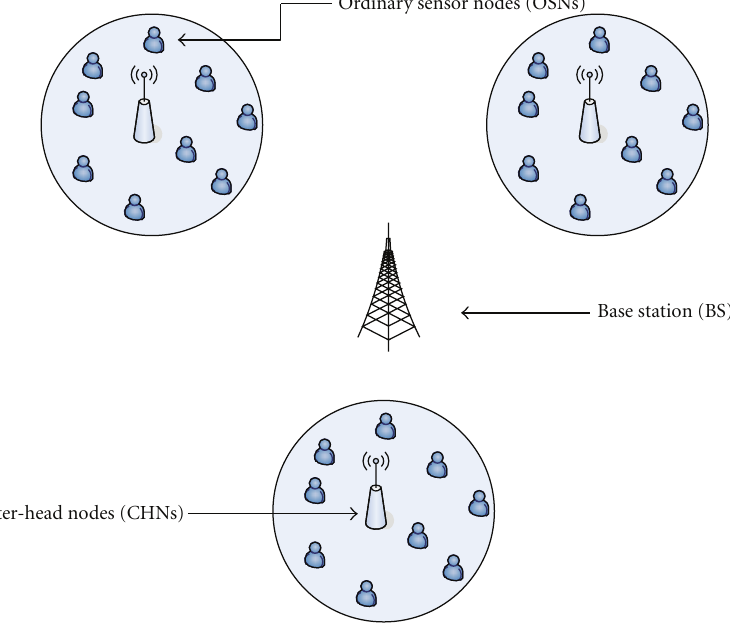
Figure 1: Physical topology for two-tier wireless sensor